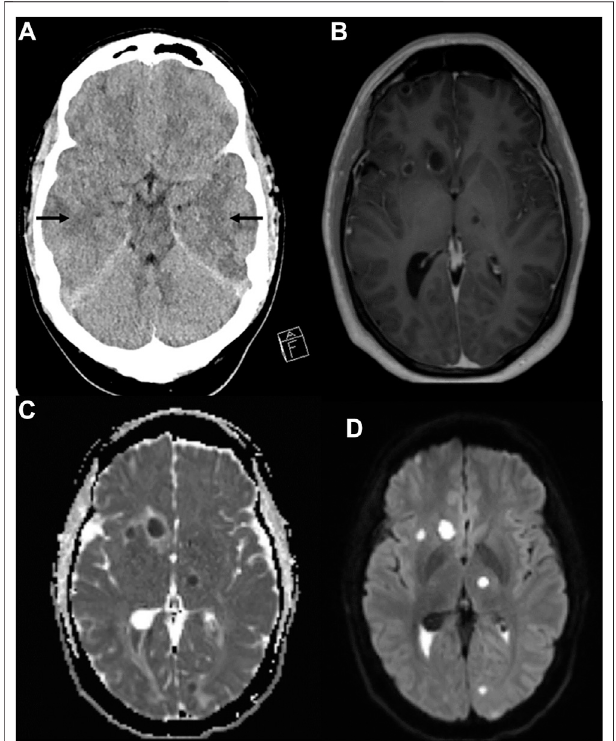
FIGURE1| Computer tomographyshowinghypodenseareasbilaterally inthetemporallobesindicatingedema(arrows) (A) .MRIofthebrainwithT1WI with gadolinium contrast (B) , apparent diffusion coef fi cient (ADC) image (C) , and diffusion-weighted imaging (DWI) (D) . Multiple peripherally contrast- enhancing lesions with perilesional edema were found both supra- and infratentorial (B) . A thin ependymal contrast enhancement is found. Diffusion imaging (C,D) show reduced signaling in the parenchymal lesions and in the content of the posterior horns, indicating multiple abscesses and